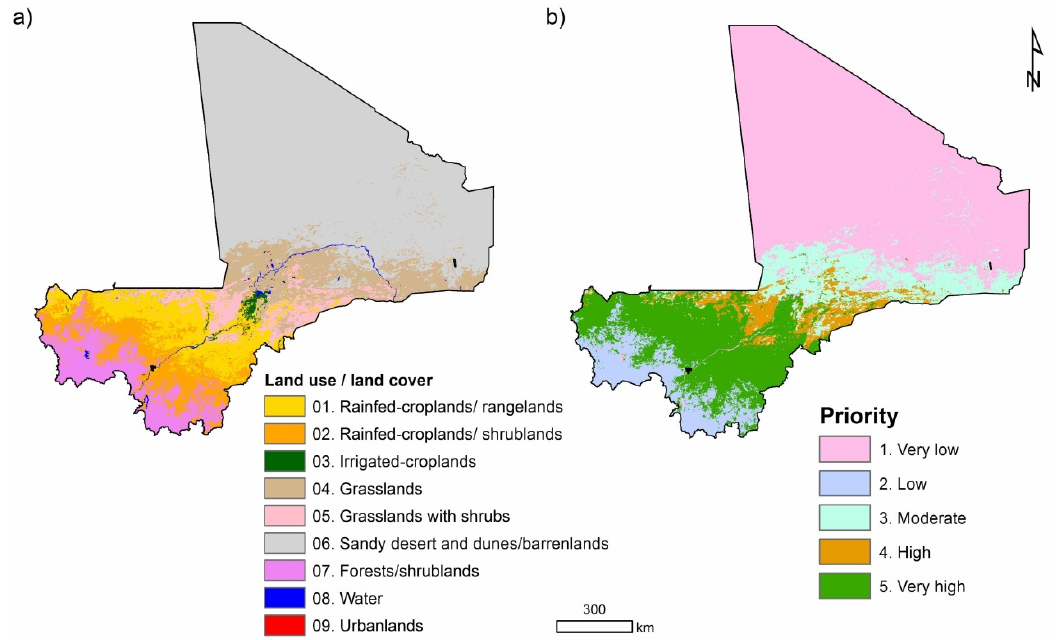
Figure Figure 5. Land use/land cover classes in Mali, during 2000: ( a ) land use/land cover; and ( b ) priority category. Table 2. Spatial distribution of the various parameters/themes, identified units within each theme and their associated areal extent within the study area.